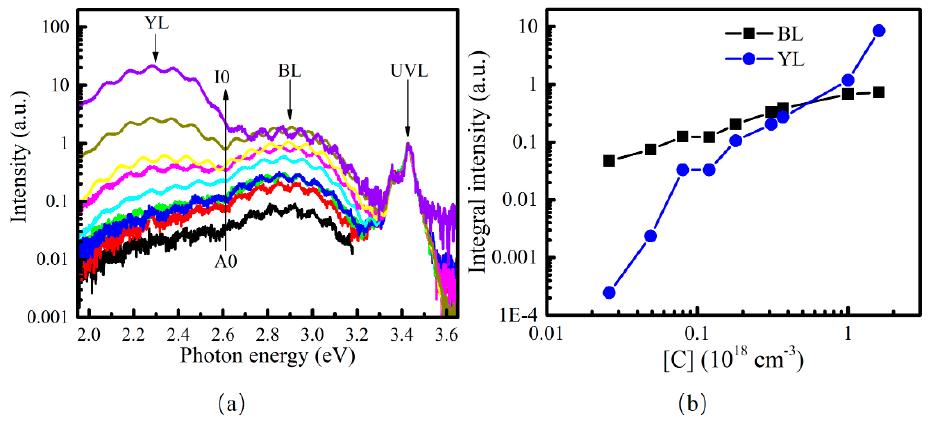
Figure 3. ( a ) Normalized room temperature PL spectra; and ( b ) the dependences of integral intensities of BL (square) and YL (circle) bands on the C concentration based on the data points of samples A0–I0 (from left to right).